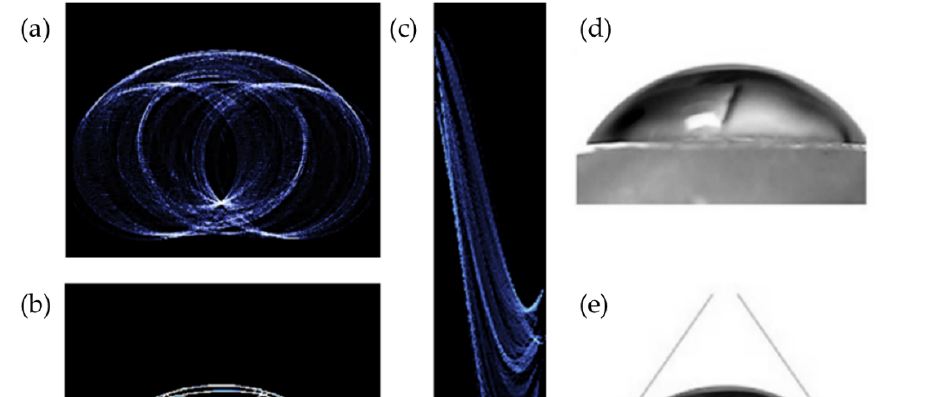
Figure 2. Experimental setup.